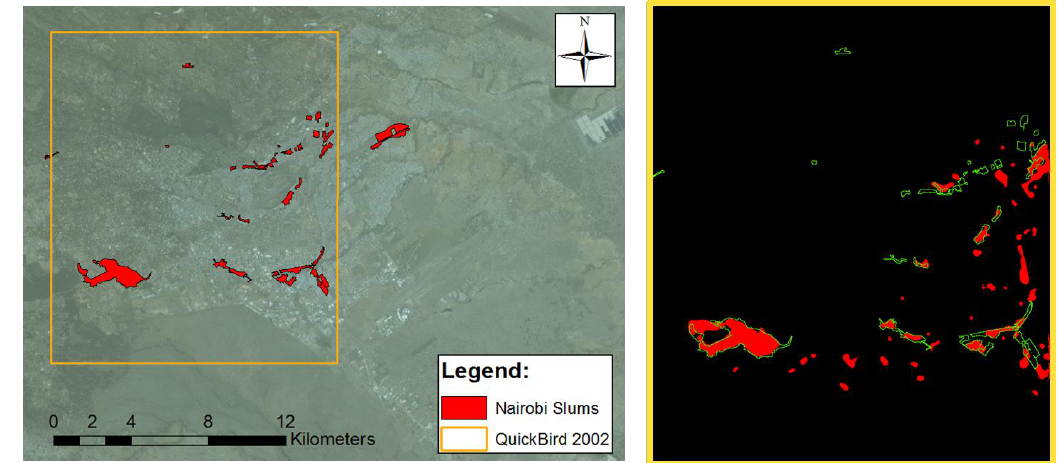
Figure 4. Informal settlement extraction. On the left, the area of Nairobi (Kenya) covered by the 2002 Quickbird image used in this work, with the slum extents provided by UN-Habitat superimposed in green; on the right, in red the overall slum extents extracted by the proposed algorithm compared with the boundaries of the ground truth, still in